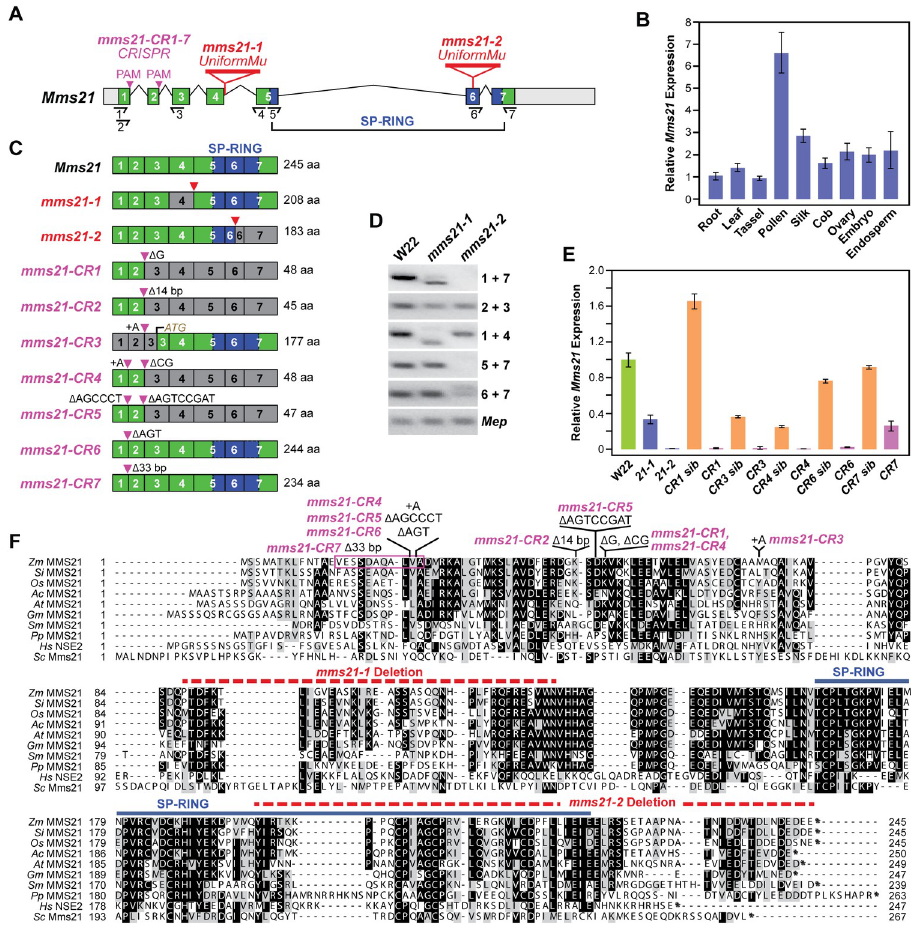
Fig 1. Description of Maize Mms21 and a Collection of Mutant Alleles. (A) Gene diagram of Mms21 . Grey and colored boxes represent UTR and coding regions, respectively. Introns are denoted by bent lines. The coding region for the SP-RING domain is shown in blue. Primers used for RT-PCR analysis in panel D and qRT-PCR analyses in panels B and E are located the half arrows. Locations of UniformMu ( mms21-1 and mms21-2 ) and CRISPR/Cas9 mutagenic sites ( mms21-CR1 to -CR7 ) are indicated. (B) qRT-PCR analyses of Mms21 gene expression in different maize tissues. Tissues were sampled from a W22 plant at flowering. The expression level of Mms21 in roots was arbitrarily set as 1 using expression from Act1 as an internal standard (n = 4 technical replicates, ± SD). (C) Mms21 mRNA architecture and expected size of the wild-type and predicted mutant polypeptides. Coding region(s) omitted from the mutant mms21 transcripts are colored in grey. The specific nucleotide insertions and/or deletions in the mms21-CR alleles are shown. The predicted ectopic ATG start codon in the mms21-CR3 allele is indicated. (D) RT-PCR analysis of the UniformMu mms21-1 and mms21-2 alleles. RT-PCR of the Mep locus was used to verify analysis of equal amounts of RNA. (E) Comparison of Mms21 gene expression among the collection of mms21 alleles. Total RNA was isolated from shoots collected 10-DAS. The expression level of Mms21 in W22 was arbitrarily set as 1 using expression of Act1 as an internal standard (n = 4 technical replicates, ± SD). (F) Amino acid sequence alignment of MMS21 proteins from plants, yeast and humans, along with the position of the mutations found in the maize allele collection. Black and grey shading indicate identical and similar amino acids, respectively. The amino acid length of the wild-type proteins is shown at the end of the sequence. The region encompassing the SP-RING domain is located by the blue line. The coding sequences expected to be absent in the mms21-1 and mms21-2 mutants are located by the dashed red lines. Zm , Zea mays; Si , Setaria italica , Os , Oryza sativa; Ac , Aquilegia coerulea; At , Arabidopsis thaliana , Gm , Glycine max; Sm , Selaginella mollendorffii; Pp , Physcomitrella patens ; Hs , Homo sapiens ; and Sc . Saccharomyces cerevisiae